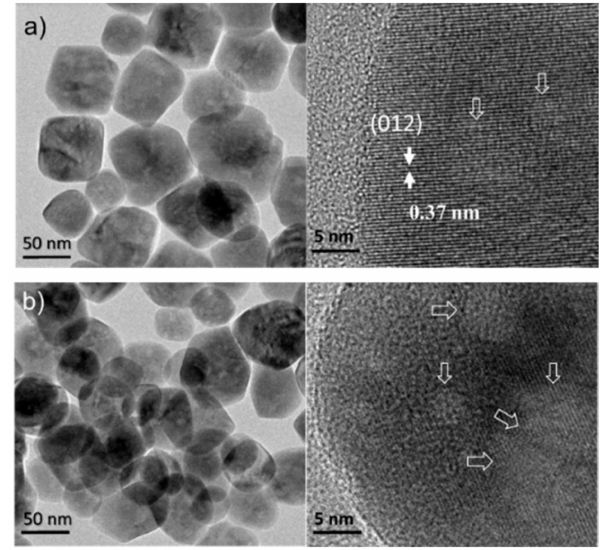
Figure 7. High-resolution transmission electron microscopy (HRTEM) images of the Fe-HT catalyst ( a ) before use and ( b ) after three catalytic cycles. Arrows indicate